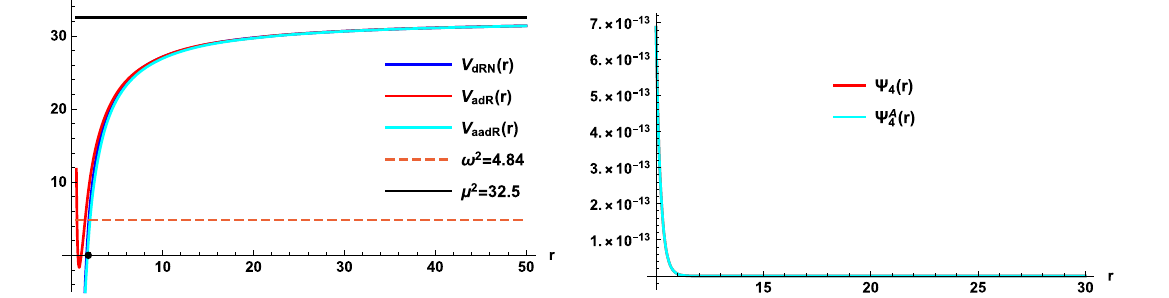
Fig. 7 (Left) Increasing potential V dRN ( r ) (cid:17) V adR ( r ) (cid:17) V aadR ( r ) as function of r ∈ [ r + = 1 . 81 , 50 ] with M = 1 , Q e = 0 . 43 , Q m = 0 . 4 ,ω = 2 . 2 , q = 5 , l = 4 ,μ = 5 . 7. A local minimum of V adR ( r ) is